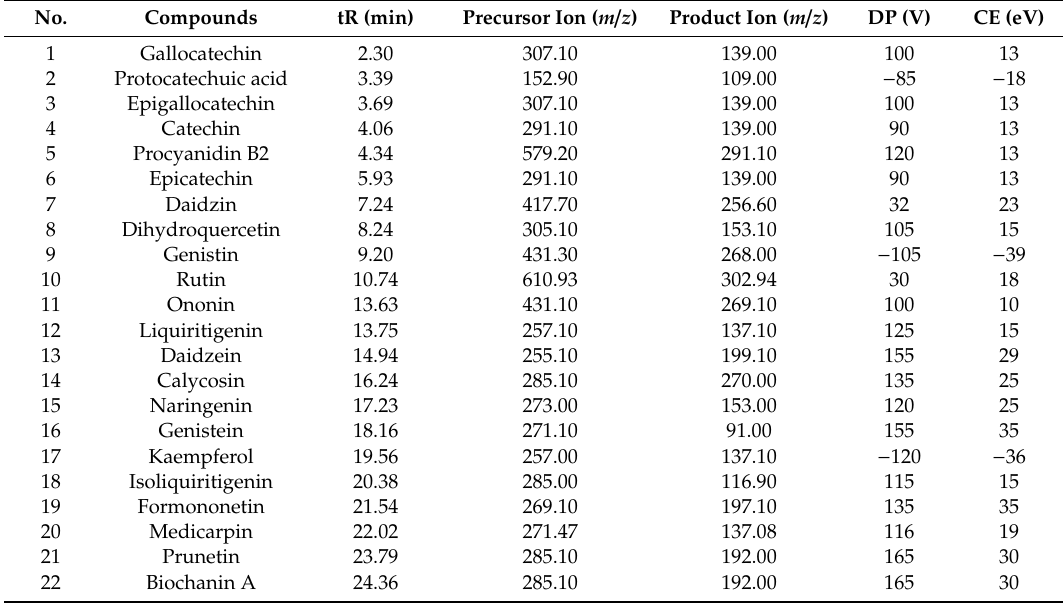
Table 1. Retention time, related mass spectrometer data of the standard